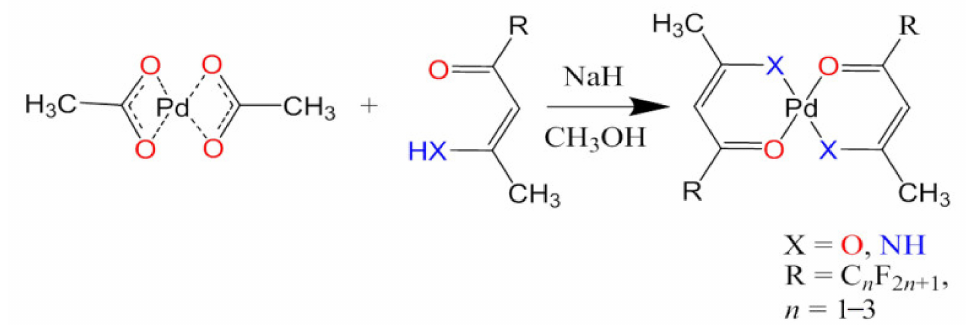
Scheme 1. The general scheme for synthesis of the complexes 1 – 6 .